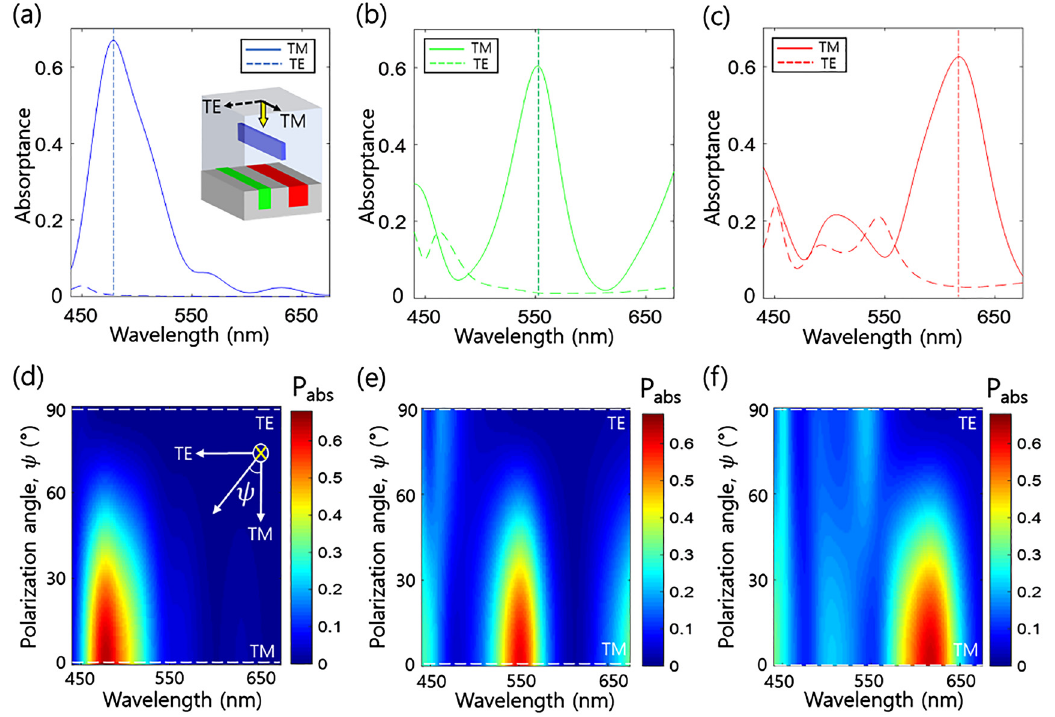
Figure 5: Simulated nanobeam absorption under the incident light with two orthogonal polarizations. (a)Theabsorptionspectrumoftopnanobeamarray(nanobeam1)fortransversemagnetic(TM)polarization(solidline,electricfieldparallelto the axis) and transverse electric (TE) polarization (dashed line, electric field orthogonal to the axis). Inset shows the cross-sectional image of integrated metasurfaces and the polarization of incident light. (b,c) The absorptionspectrumof the small (nanobeam2) andlarge (nanobeam 3) nanobeamarray at the bottom underTMand TE polarizations. The absorptionspectrumsof three nanobeamarraysshow morethan 60%at TMpolarizationviaMieresonanceexcitedbythenanobeams.(d,e,f)Mapofthespectralabsorptioninthenanobeamarray1(d),thenanobeam array 2 (e), and the nanobeam array 3 (f) as the function of the angle of polarizations ( ψ ) with respect to the nanobeam ’ s axis. The composed